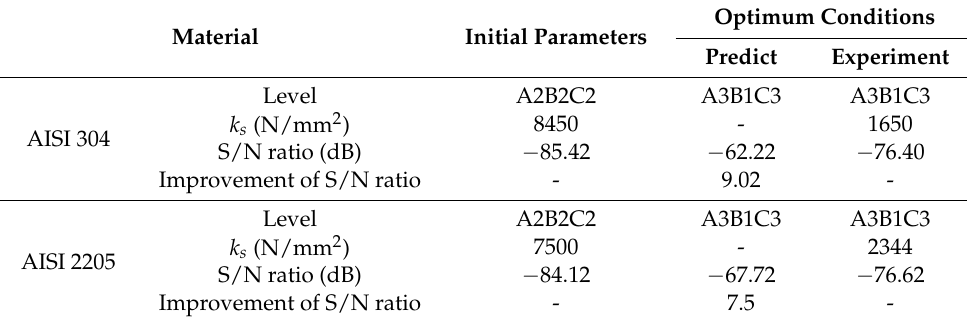
Table 13. Results of the confirmation experiment for specific cutting